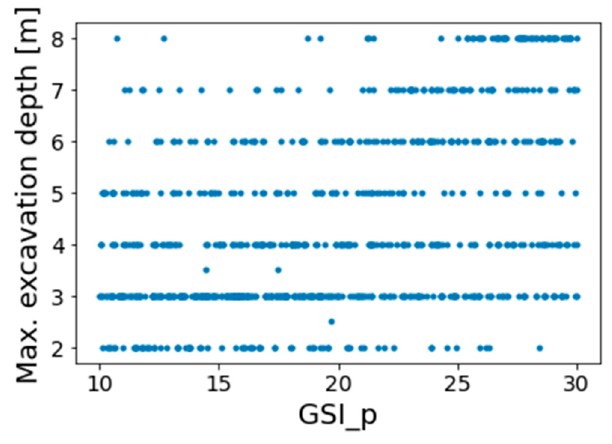
Figure 5. The plot of peak GSI vs. maximum excavation depth.